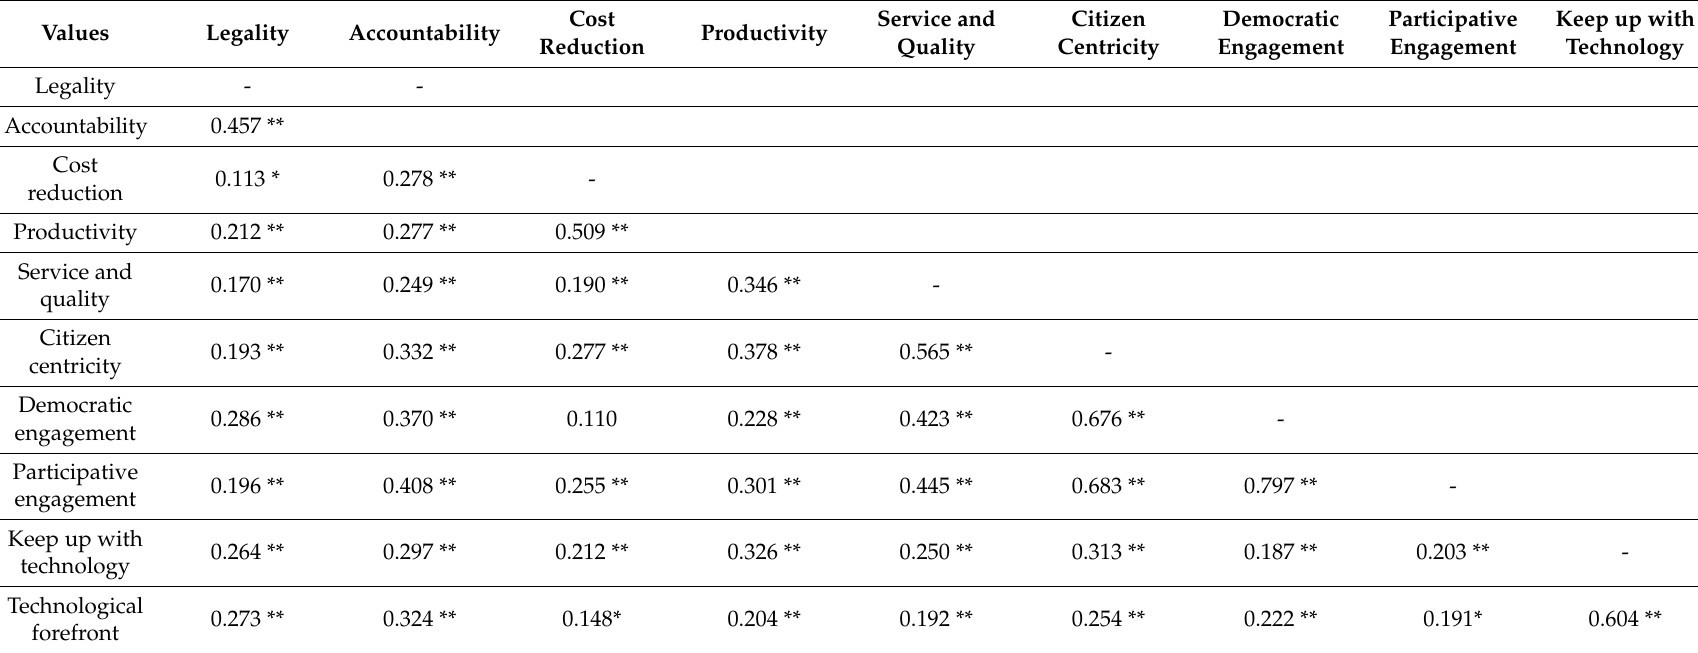
Table 10. Correlations between